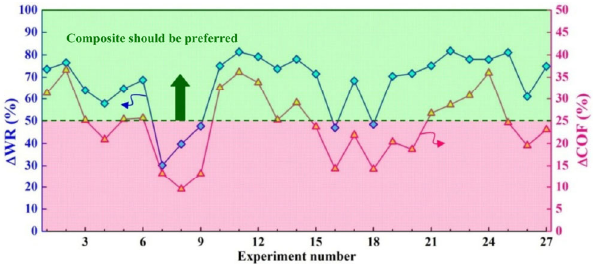
Fig. 11 Variations of ∆ WR and ∆ COF with respect to 27 experiments.